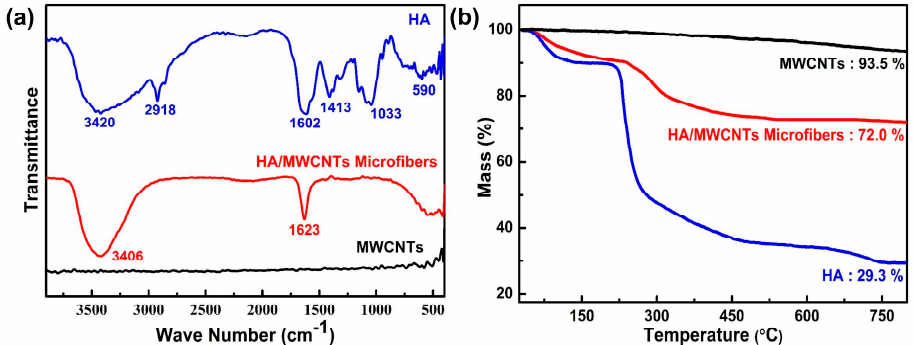
Figure 7. FTIR spectra and TGA curves of HA, MWCNTs, and HA / MWCNT hybrid microfibers. ( a ) FTIR spectra; ( b ) TGA curves.